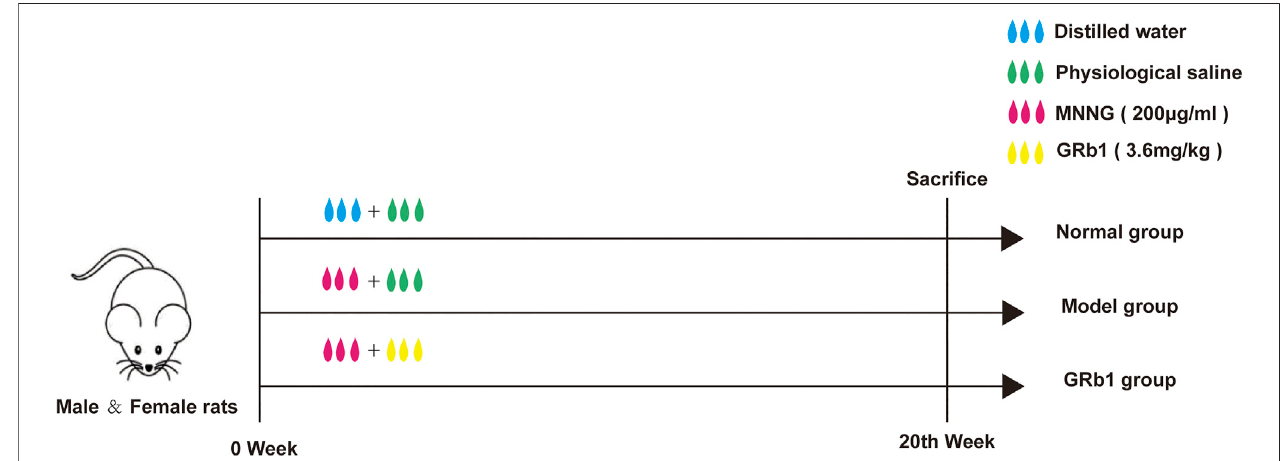
FIGURE 1 | Experimental fl ow chart of MNNG-induced animal model and GRb1 treatment. (A) Normal group (treated with distilled water and physiological saline); (B) Model group (treated with MNNG and physiological saline; model group); (C) GRb1 group (treated with MNNG and GRb1). Abbreviations: MMNG, N-methyl-N ′ - nitro-N-nitrosoguanidin; GRb1, ginsenoside